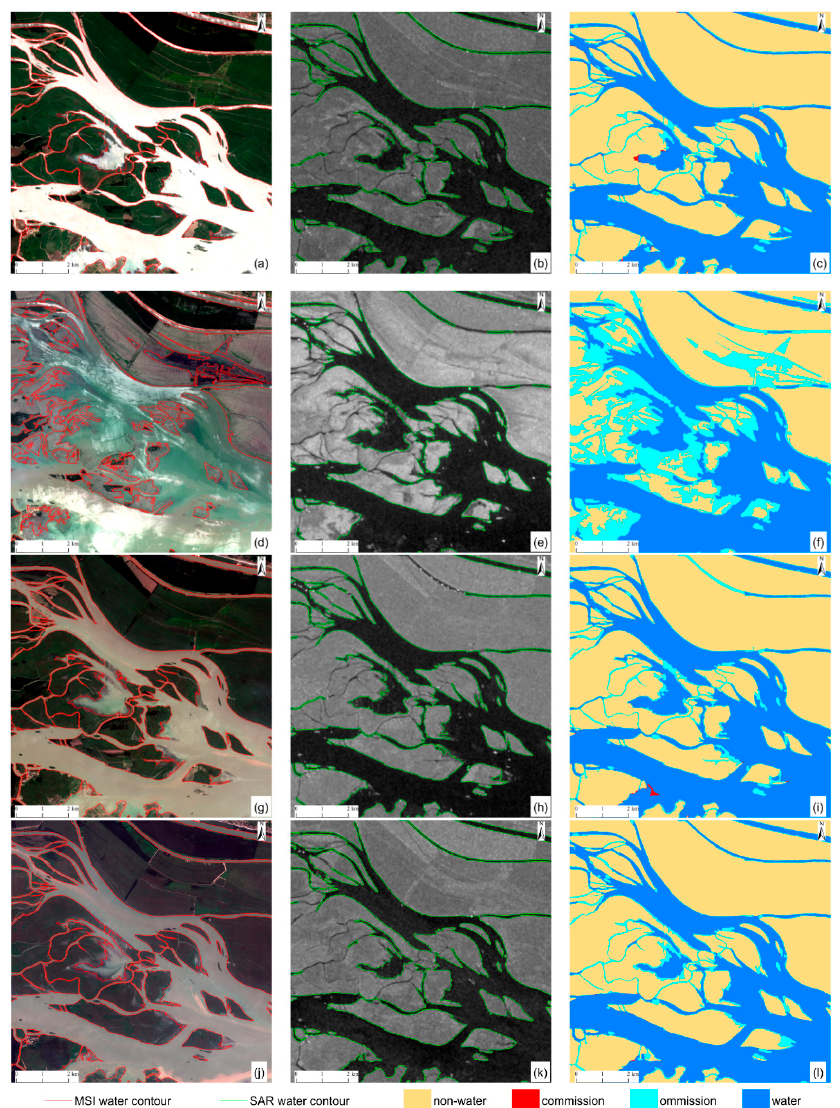
Figure 5. The extracted water contours and final water classification overlays for Sentinel-2 MSI (as reference) and Sentinel-1 SAR for validation site A: ( a ), ( d ), ( g ), and ( j ) represent water contours derived by automated water extraction index (AWEI) method and true color compositions of Sentinel-2 MSI acquired on 18 May 2017, 17 July 2017, 15 September 2017, and 5 October 2018, respectively; ( b ), ( e ), ( h ), and ( k ) are extracted water contours using proposed method and Sentinel-1 SAR scene in VV polarization acquired on 23 May 2017, 22 July 2017, 20 September 2017, and 9 October 2018, respectively; ( c ), ( f ), ( i ), and ( l ) are overlays of the final water classification from Sentinel-1 SAR and Sentinel-2 MSI.